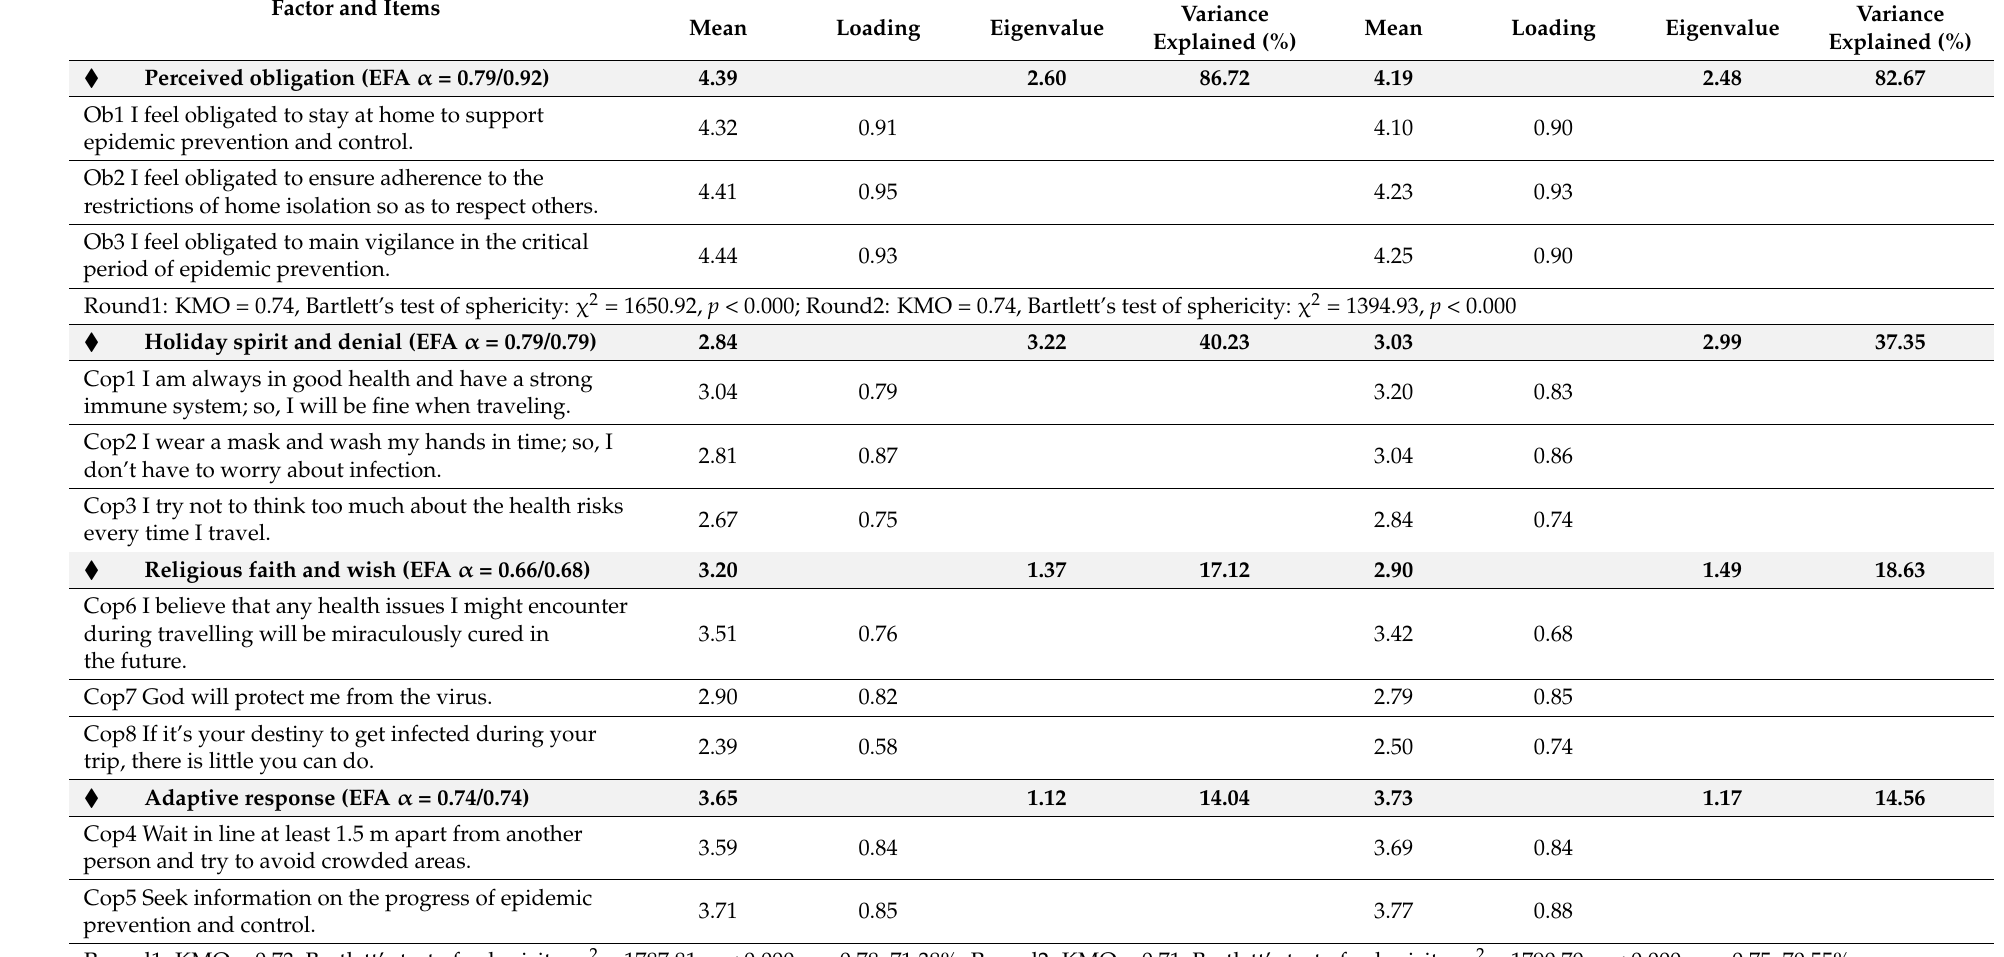
Table 2. Results of the factor analyses on perceived obligation, coping response, attitude and intention items. EFA (Round1 N = 700) EFA (Round2 N = 773) Factor and Items Variance Mean Loading Eigenvalue Mean Loading Eigenvalue Explained (%)